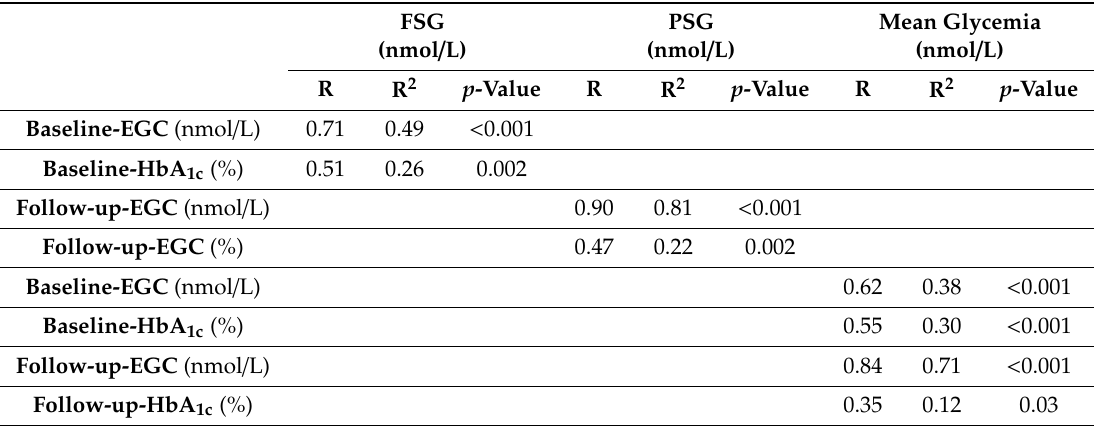
Table 7. Di ff erent correlations of baseline and follow-up measures of EGC and HbA 1c with FSG, PSG, and mean